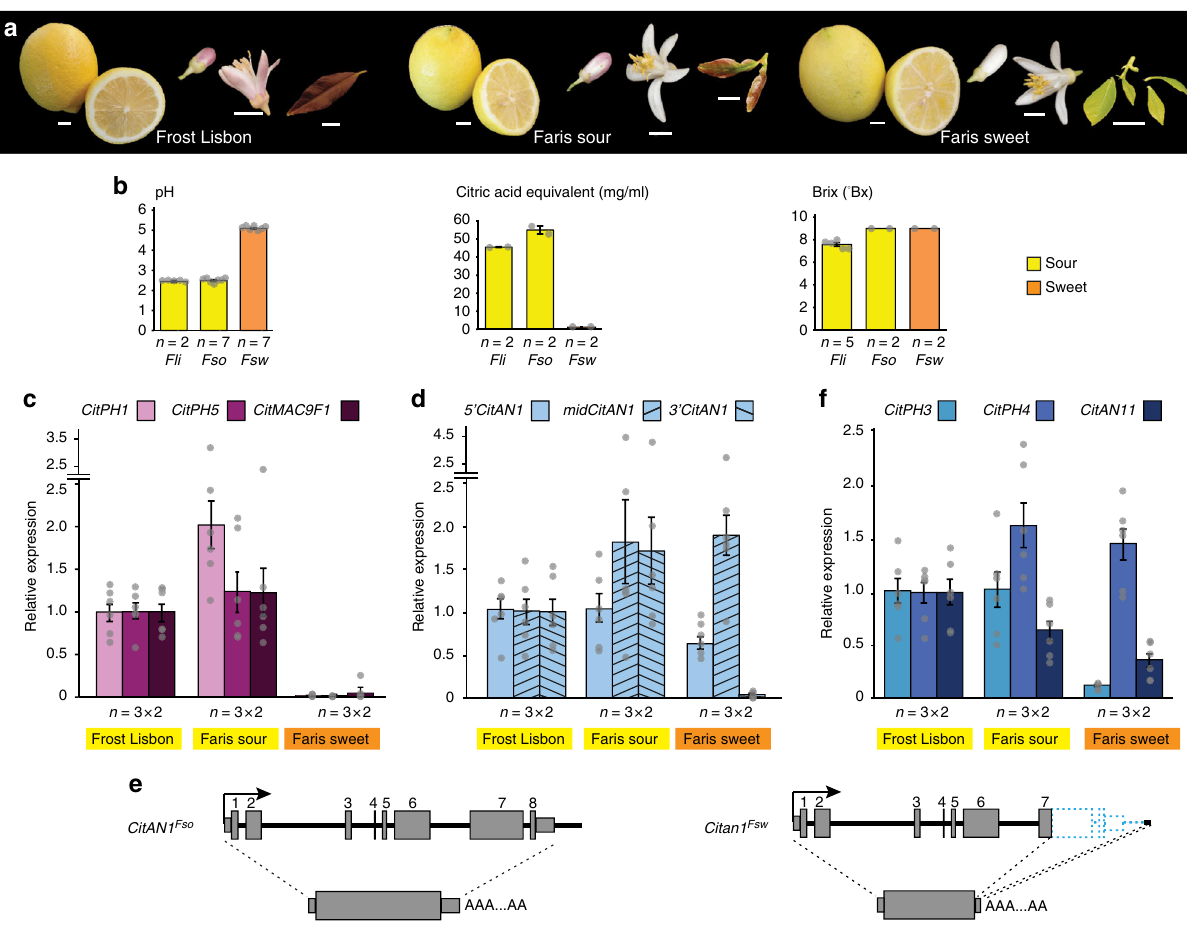
Fig. 1 Analysis of ‘ Frost Lisbon ’ ( Fli ), ‘ Faris ’ sour ( Fso ), and ‘ Faris ’ sweet ( Fsw ) lemons. a Phenotypes of Fli , Fso , and Fsw fruits, fl owers, and leaves. Scale bars represent 1 cm. b pH, titratable acid, and soluble solid content (°Brix) in juice from (nearly) mature Fli , Fso , and Fsw fruits (mean ± SE). c Real-time RT-PCR of CitPH1 , CitPH5 , and CitMAC9F1 mRNA in juice vesicles from (nearly) mature Fli , Fso , and Fsw fruits. d Real-time RT-PCR of CitAN1 mRNA in Fli , Fso and Fsw juice cells, using primers that amplify the 5 ’ , middle, and 3 ’ part of the mRNA. e Structure of the CitAN1 alleles and their transcripts in Fso and Fsw juice vesicles. f Real-time RT-PCR of CitPH3 , CitPH4 , and CitAN11 mRNA in juice vesicles from (nearly) mature Fli , Fso , and Fsw fruits. Values in c , d , f are mean ± SE; n = number of samples from different fruits × number of technical replicates of each. Source data are provided as a Source Data fi